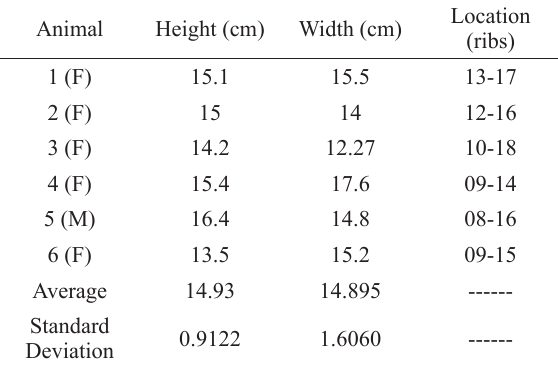
Biometric values of the diaphragm muscle of the Southern